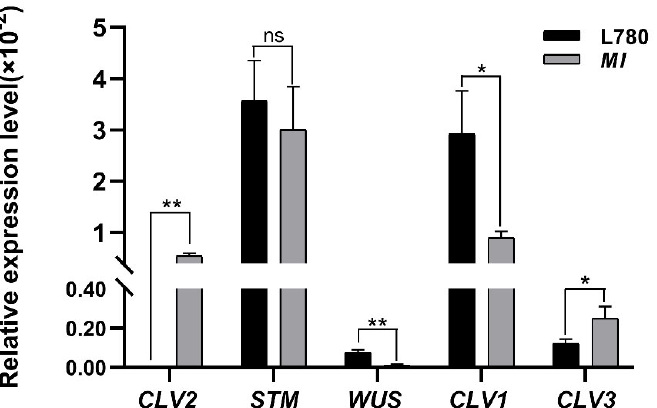
Figure 1. Multi inflorescence-related traits and morphology of shoot apical meristems (SAMs) in MI . ( a , b ) Plant morphology of L780 ( a ) and MI ( b ); bar = 10 cm. Inflorescence meristems (IM) of L780 ( c ) and MI ( d ) in initial stage of IM differentiation. Black arrows indicate SAM; bar = 100 μ m. Comparison analysis of plant height ( e ) and leaf number ( f ) between wild type and MI . Error bars indicate SD ( ** p < 0.01; Student’s t test).